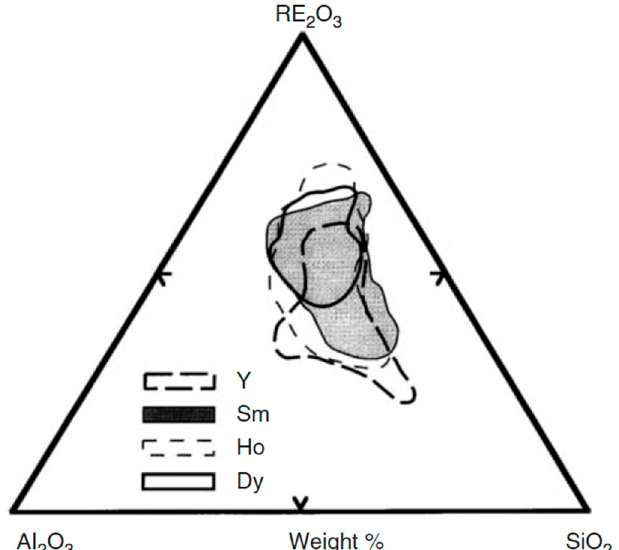
Figure 4. Compositional ternary diagram showing the glass formation range for REAS compositions that melt below 1600 °C. Yttrium, while not being rigorously a rare earth element, is comprised in the diagram because it has similar properties to those of rare earths [12].